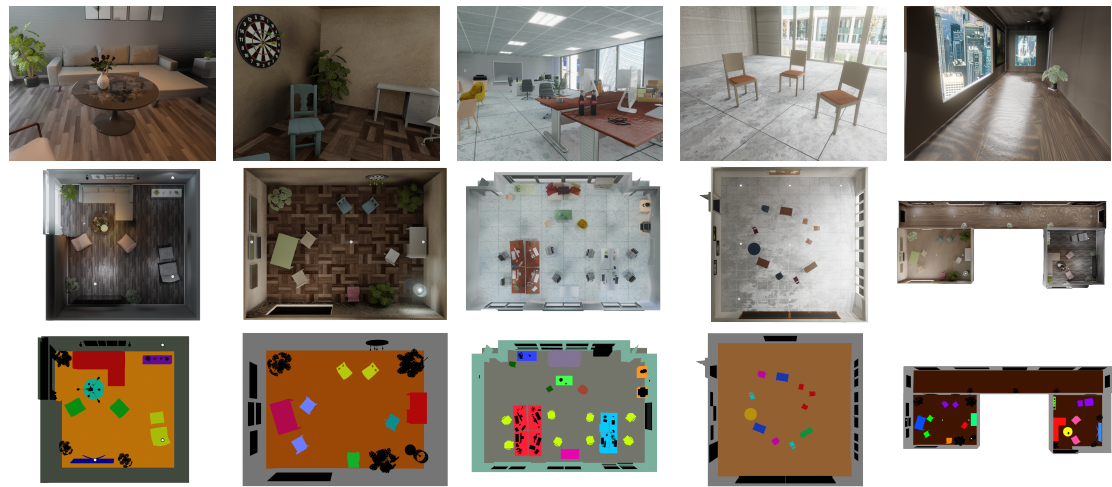
Figure 6. An overview of five provided datasets with RGB images from the sequence at the top, a top view of the scene in the middle, and a top view of the semantic maps at the